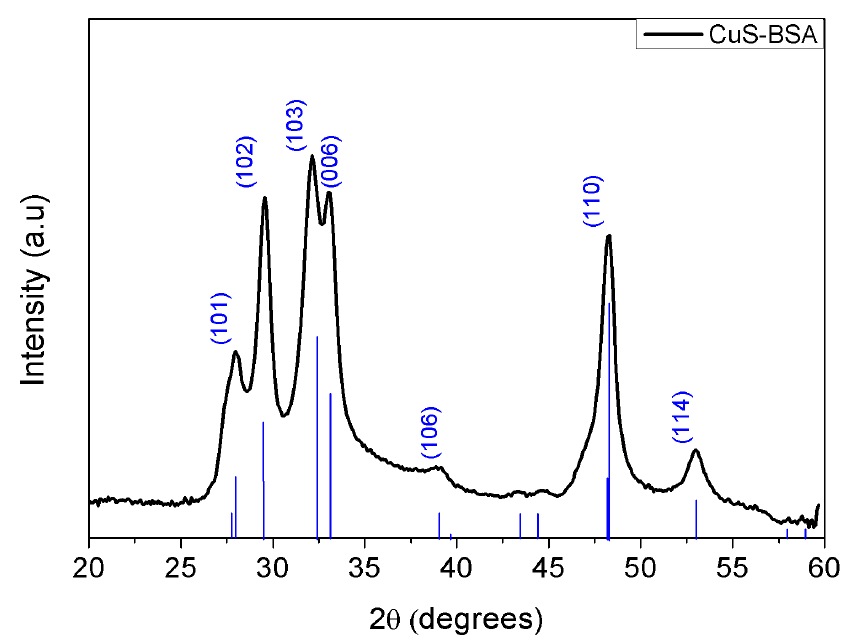
Figure 2. X-ray diffraction (XRD) plot of CuS-BSA NPs.